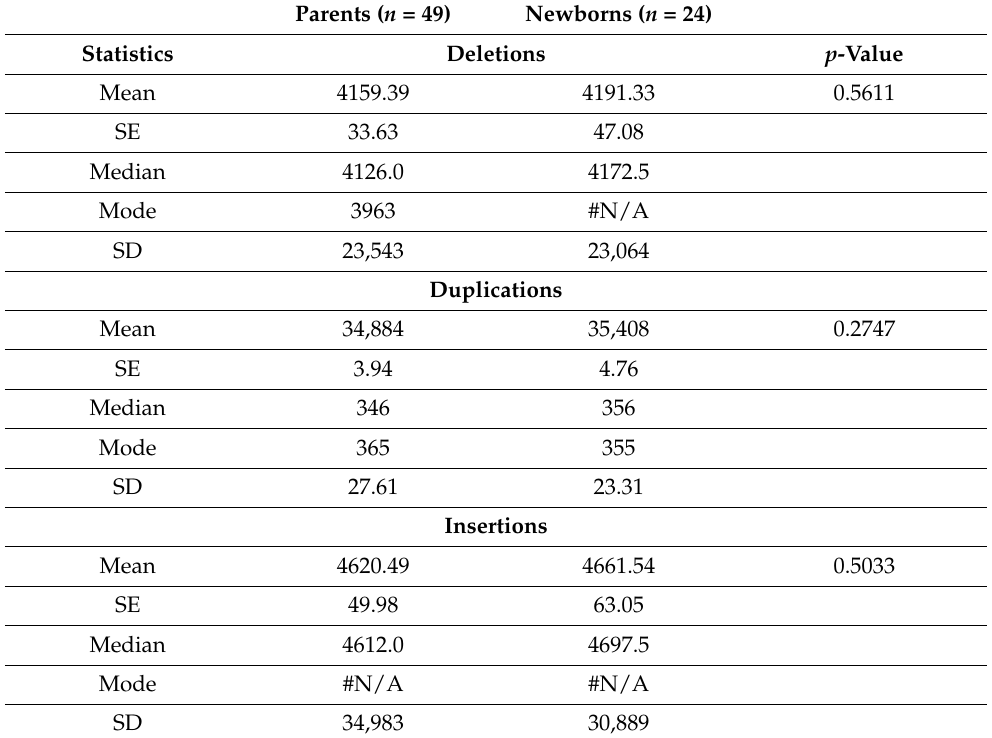
Table 2. Summary statistics for deletions, duplications, and insertions in parent and newborn